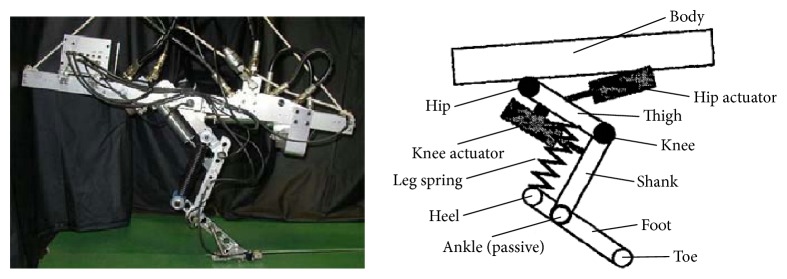
Jumping robot KenKen [36].